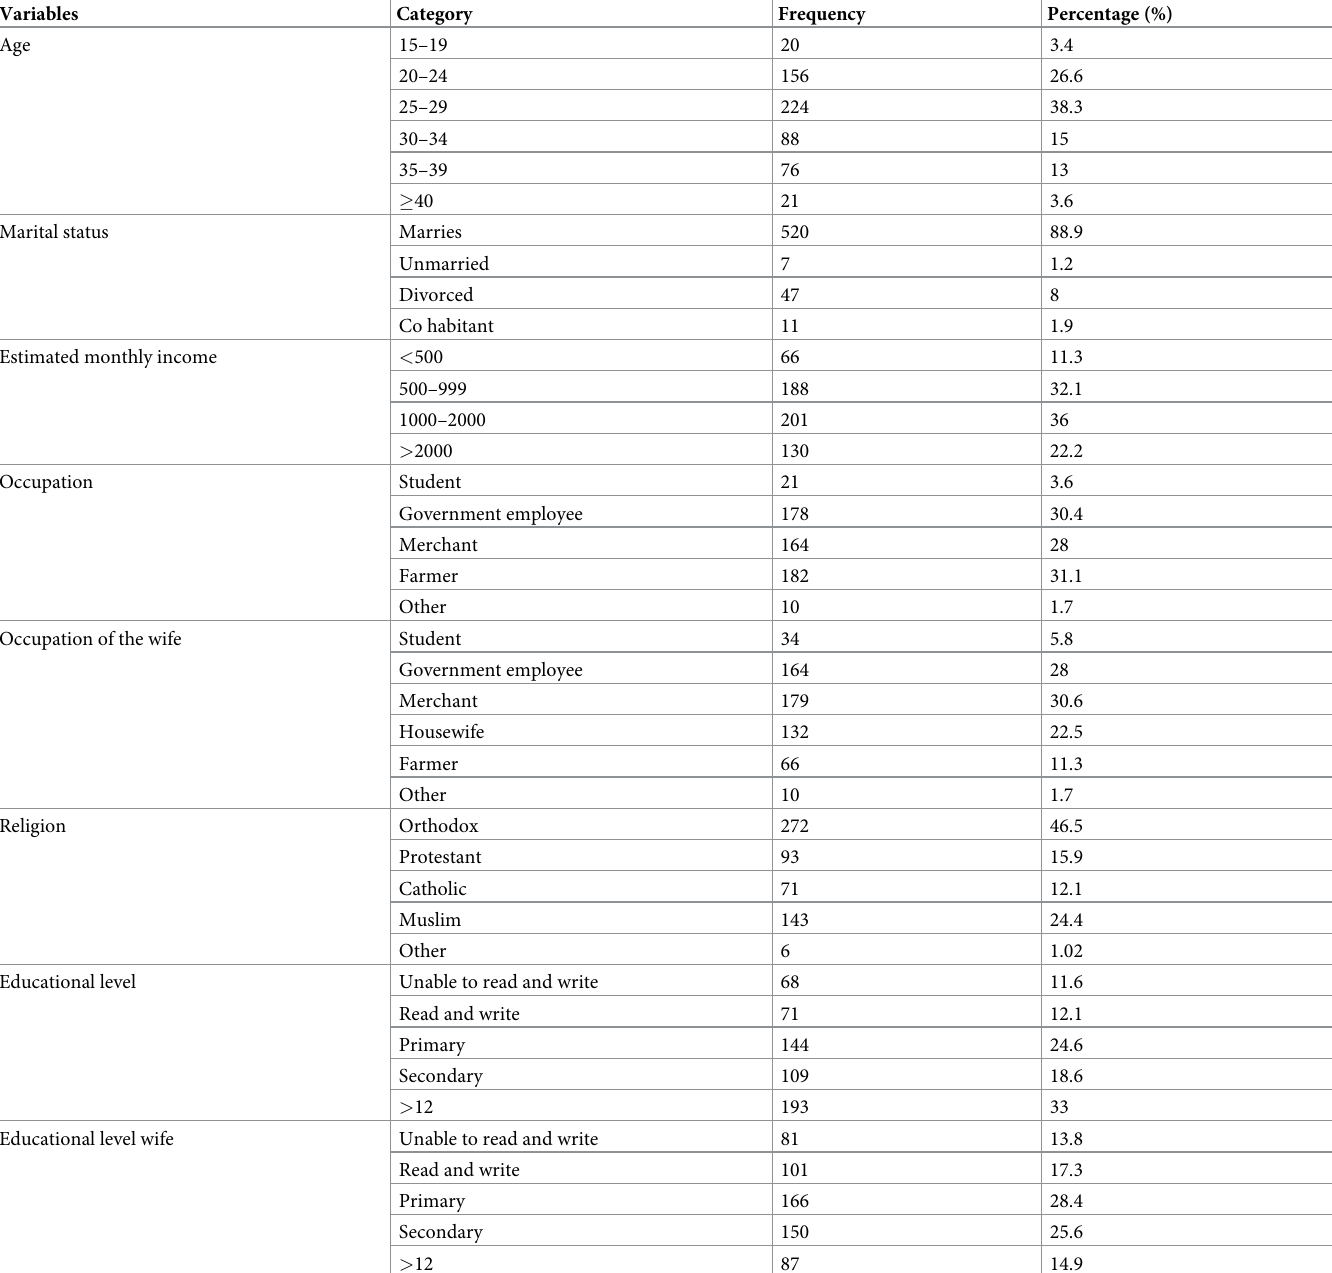
Table 1. Sociodemographic characteristics of respondents for the study to assess knowledge of fathers whose wife delivered in the last 1year towards breastfeeding and its associated factors.